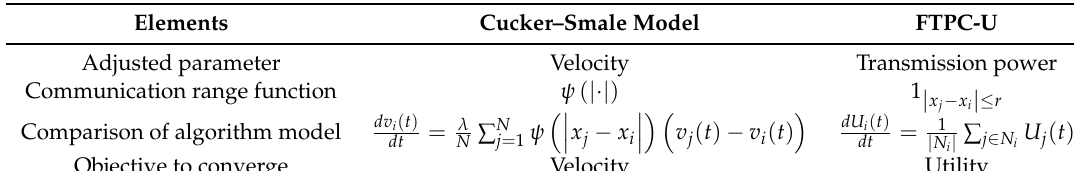
Table 1. Comparison between elements used in the Cucker–Smale model and the proposed algorithm. FTPC-U, locking-based transmission power control with utility.